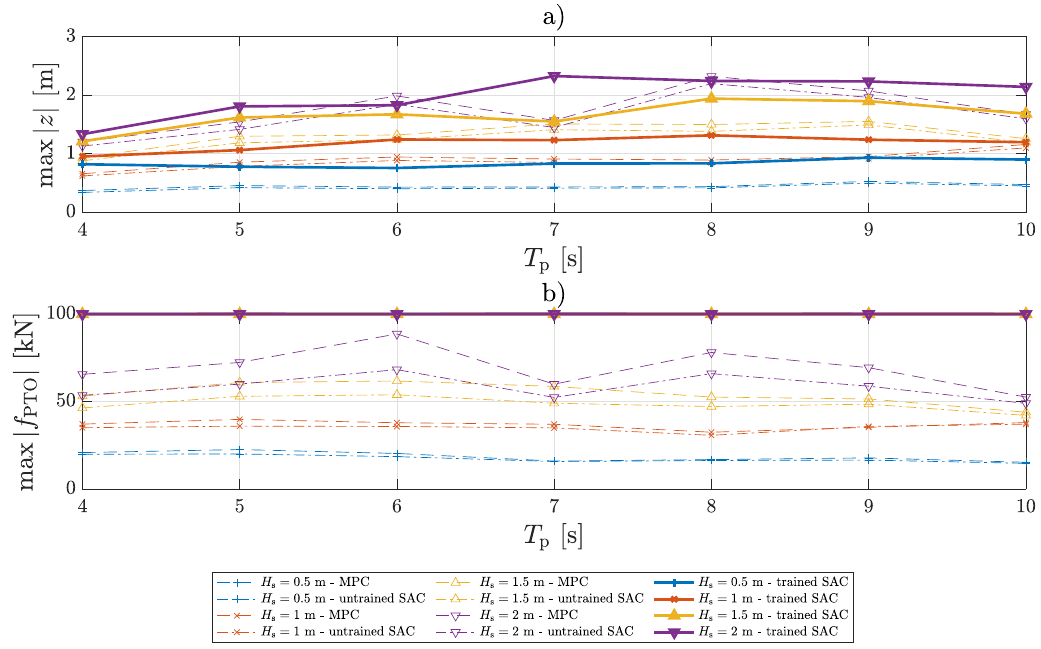
Figure 7. Variation with peak wave period of the maximum absolute displacement ( a ) and PTO force ( b ) for the heaving sphere for the considered range of significant wave